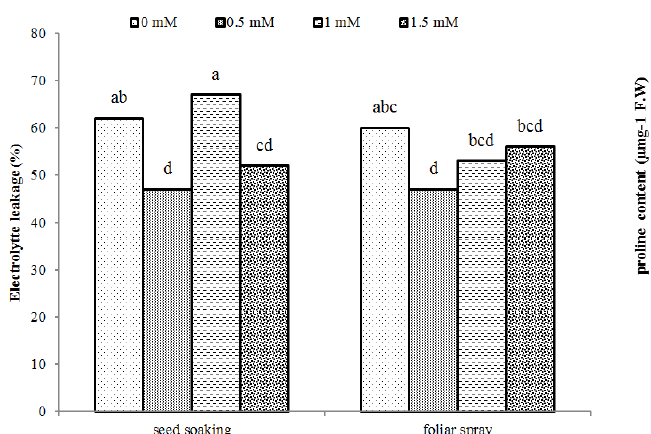
Fig. 5. Effect of SA and its application method on proline con- tent of watermelon seedling subjected to chilling stress.